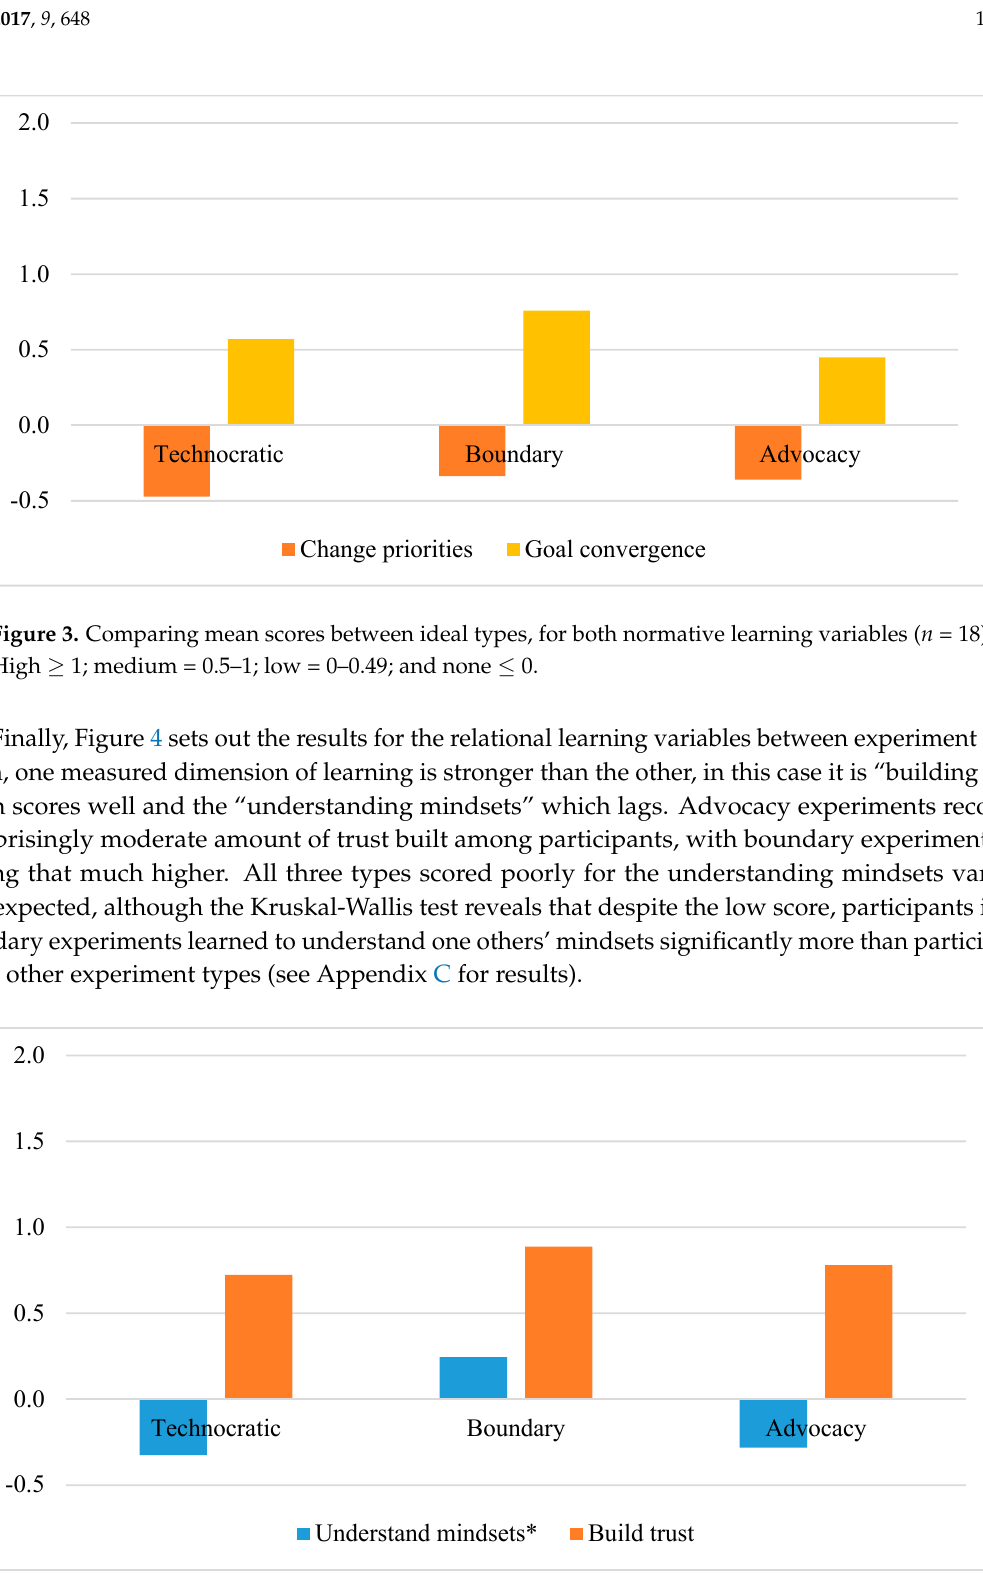
Figure 4. Comparing mean scores between ideal types, for both relational learning variables ( n = 18). High ≥ 1; medium = 0.5–1; low = 0–0.49; and none ≤ 0. The asterisk (*) denotes that for this variable, there were statistically significant differences in scores between the cases, as revealed by the Kruskal-Wallis test.